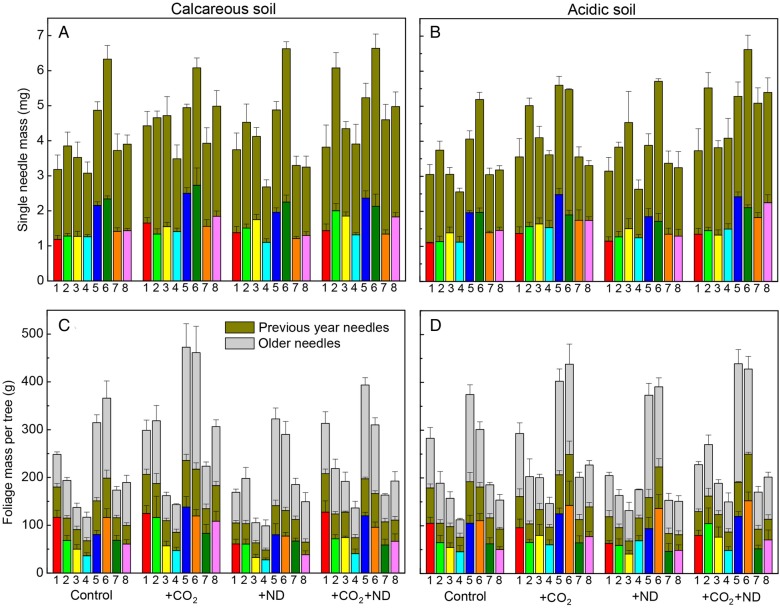
The change in the dry mass of single needles (A and B) and total crown foliage (C and D) in European spruce from eight origins growing together on either acidic or calcareous forest soil in response to +CO2, +ND and +CO2 + ND versus control (mean values + SE, N = 4, September harvest). Origins: 1 Harzvorland (red column), 2 Hochsauerland (green column), 3 Frankenwald (yellow), 4 Carpathia (cyan), 5 Kerns (blue), 6 Neuwilen (dark green), 7 Bremgarten (orange), 8 Maschwanden (magenta).